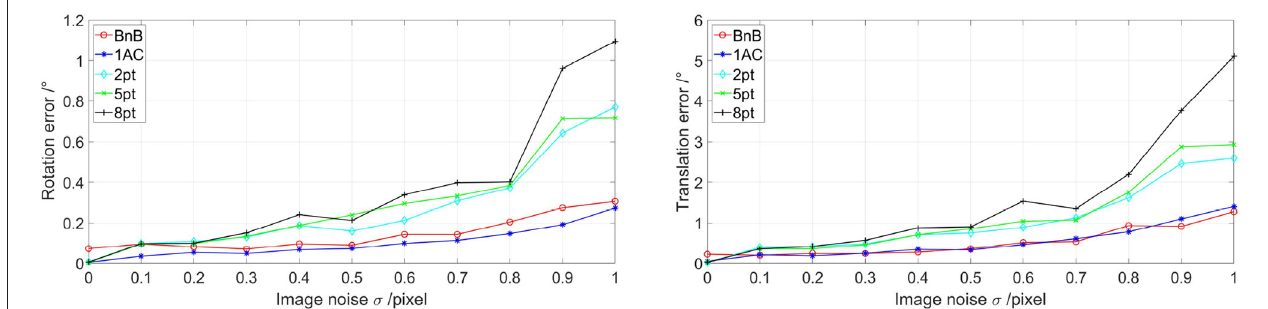
FIGURE 2 | Evaluations of five algorithms on different image noise. The non-planar noise is not added. The left image shows rotation error with different image noise and the right one represents translation error with different image noise. 1AC, 2pt, 5pt, and 8pt are the studies of Hartley and Zisserman (2003); Nistér (2004); Choi and Kim (2018); Guan et al. (2020), respectively, and BnB is our study.